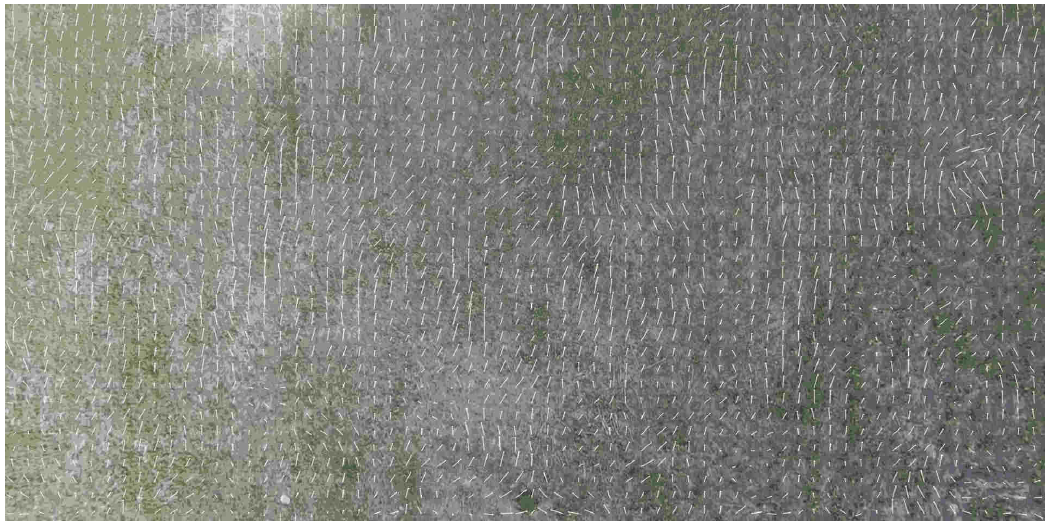
Figure 8. Optical flow estimated by Lucas-Kanade algorithm at the end of glissade, height ≈ 30 m, level of averaging 16 × 16. By comparing with Figure 6 one can observe much more regular behaviour of the optical flow which gives a better estimation of the flight parameters.